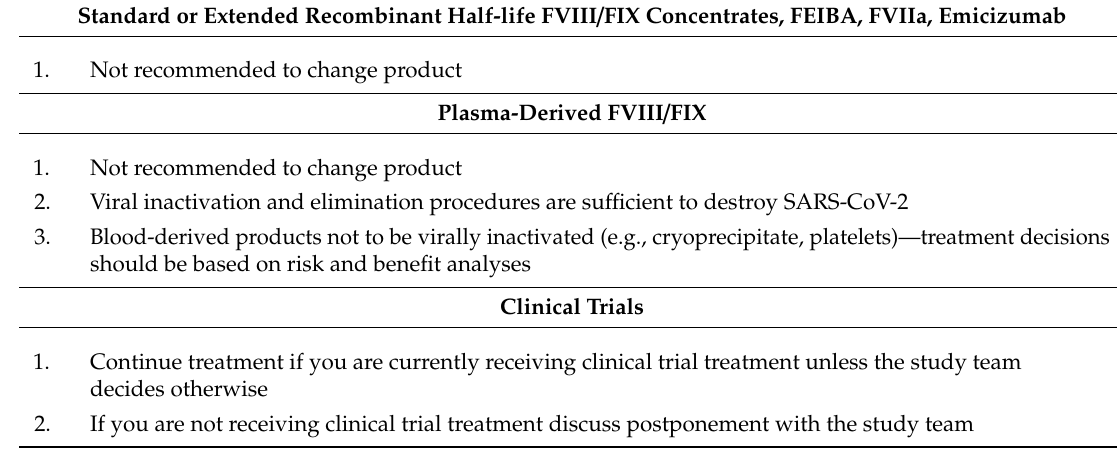
Table 3. Modified recommendations by World Federation of Hemophilia